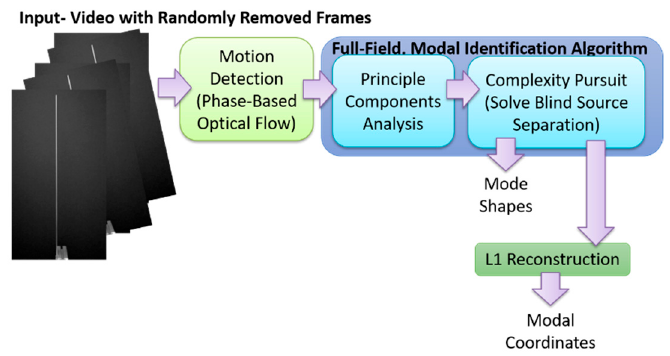
Figure 20. Algorithm for recovering mode shapes from video with frames randomly removed without the need for L1 regularization. L1 regularization is only used to recover the modal coordinates.